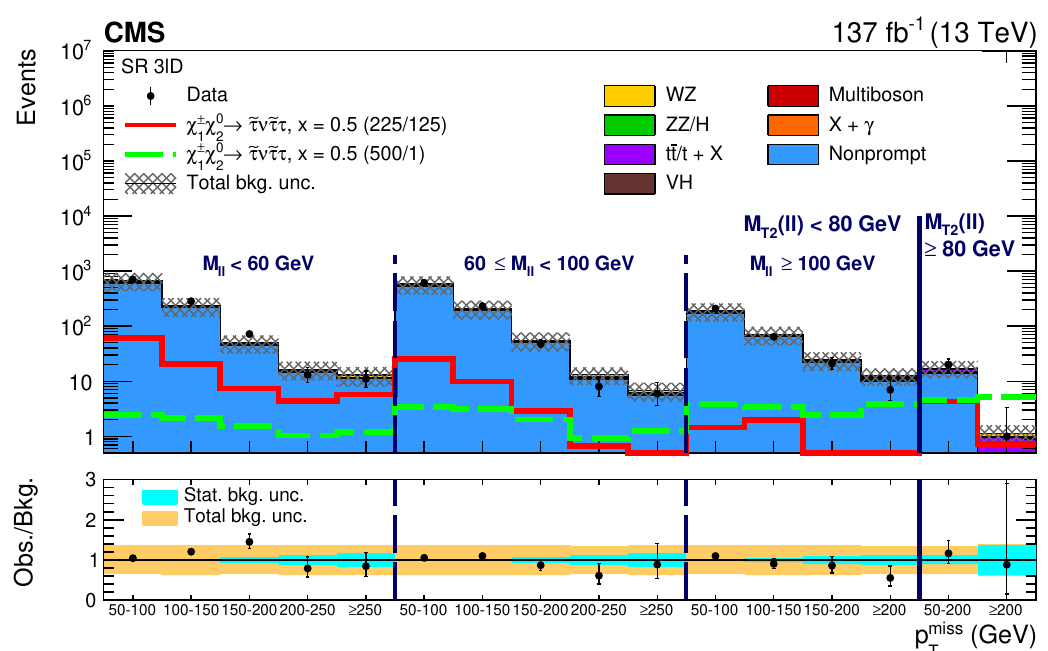
Figure 11 . Observed and expected yields across the search regions in events with an e ± m ∓ pair and a t candidate (3 ‘ D). Several signal models are shown superimposed. They correspond to h production with slepton-mediated decays in the τ lepton dominated hypothesis for a compressed δm = 100 GeV (red line) and uncompressed δm = 500 GeV (green dashed line) scenario. The legends specify the masses of